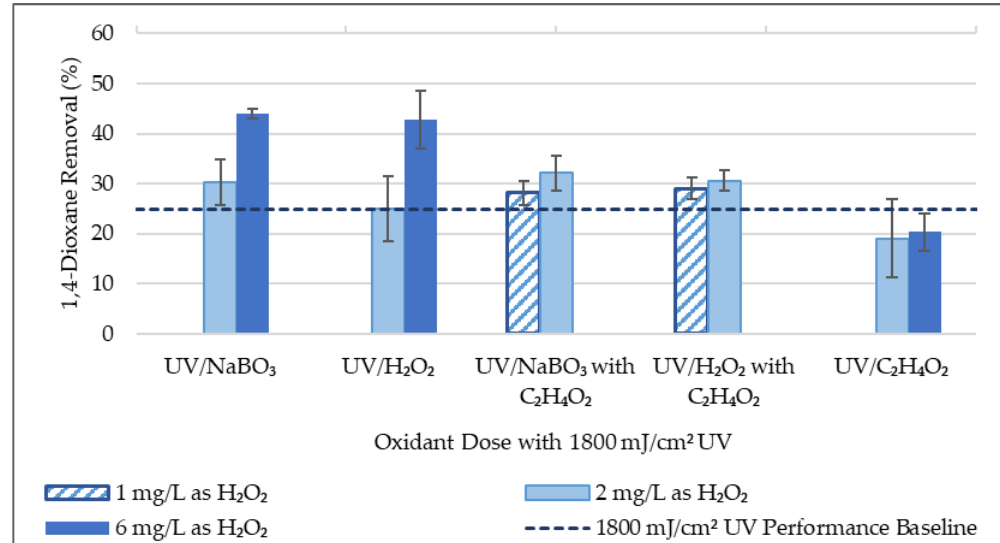
Figure 3. 1,4-Dioxane Experimental Results Summary ( ≥ 50 μg/L initial 1,4-dioxane